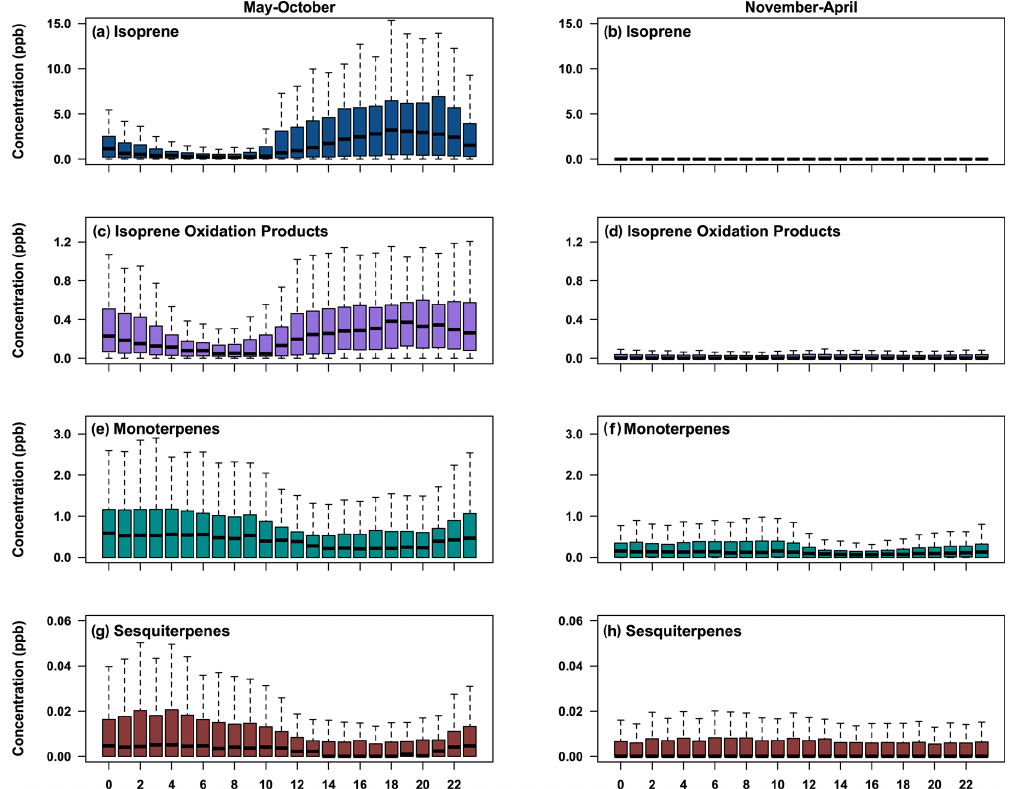
Figure 4. Binned hourly boxplots for the four BVOC classes, divided into the growing season, May–October, and the non-growing season, November–April. Classes shown are (a–b) isoprene, (c–d) isoprene oxidation products, (e–f) monoterpenes, and (g–h) sesquiterpenes. The plots show the median value as a horizontal line, and the bottom and top of each box indicate the 25th and 75th percentiles, while the whiskers represent 1.5 times the interquartile range. Each box represents the data for each hour of the